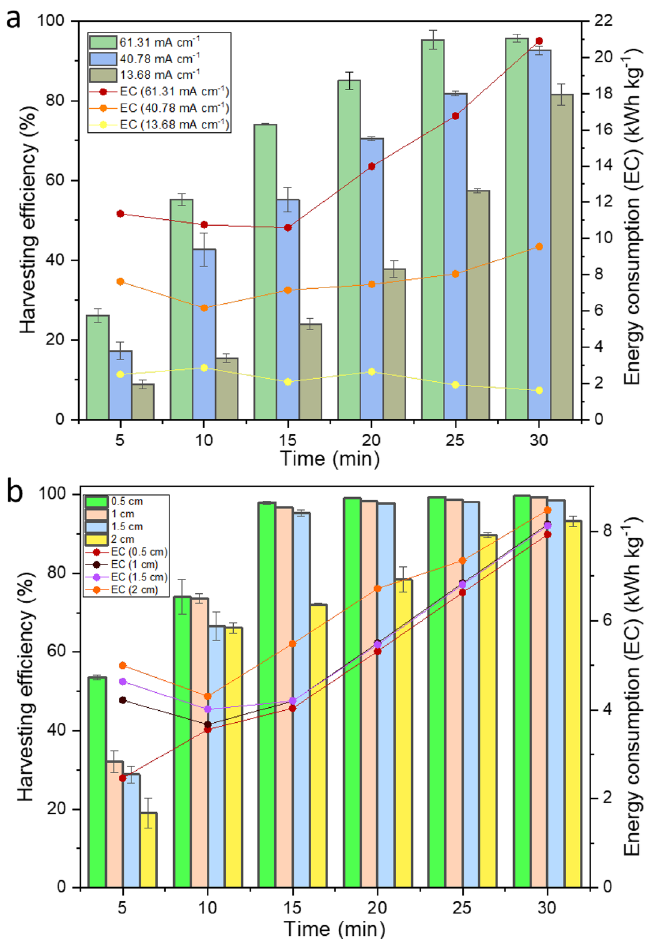
Figure 1. Optimization of ( a ) current density and ( b ) interelectrode distance for energy-efficient microalgal recovery with respect to